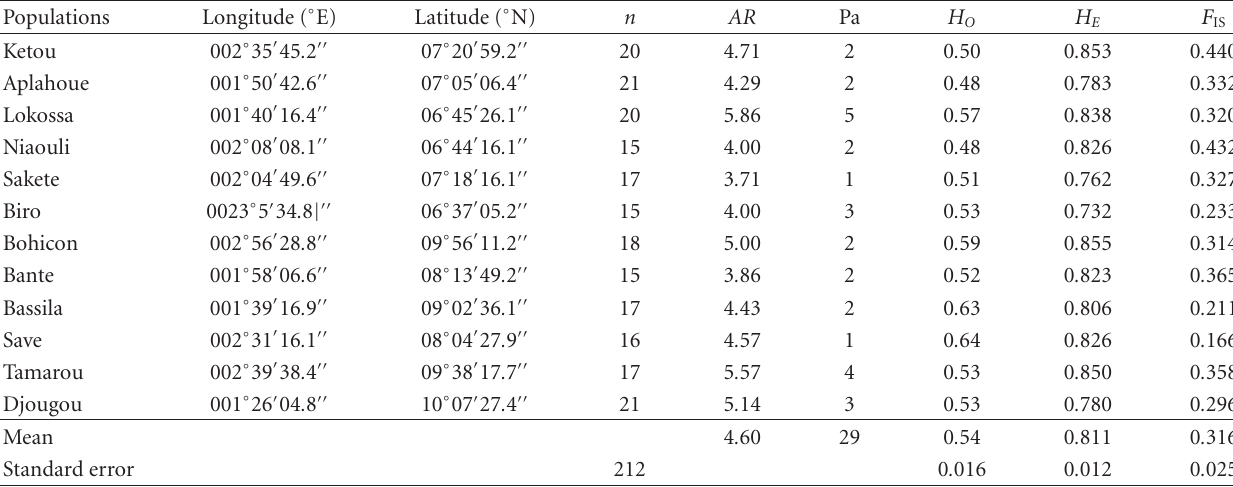
Table 1: Geographical locations and genetic diversity parameters estimated in 12 Milicia excelsa